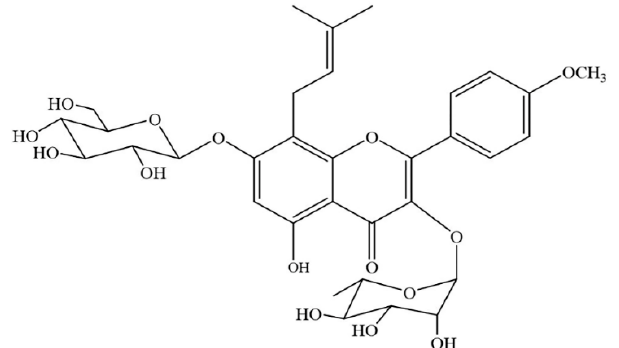
Figure 1. The chemical structure of icariin (ICA).